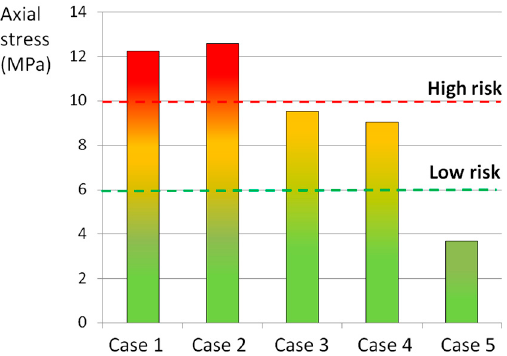
Figure 4. Average tensile axial stress generated by the loading cases listed in Table 1 in POST-LAT1 section. The red and the green lines indicated the thresholds identified as “high risk” and “low risk” of failure, respectively.